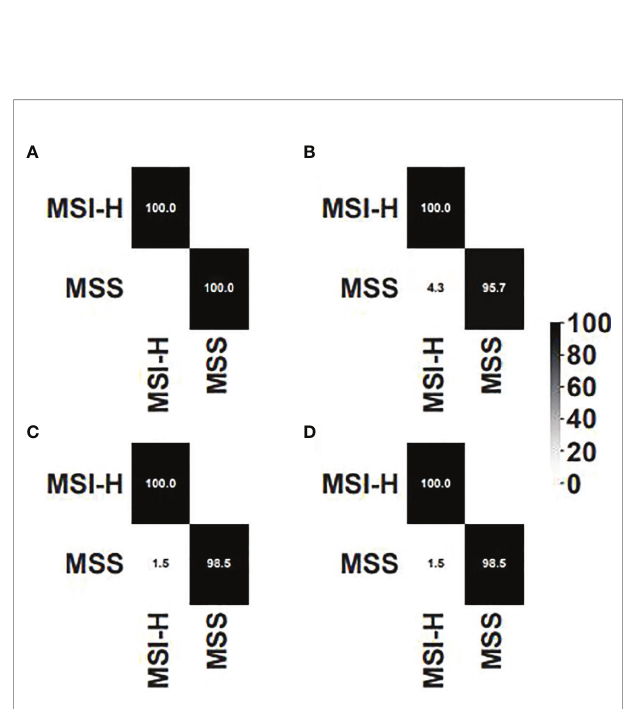
FIGURE 5 | Confusion matrix for (A) our algorithm on the validation set, (B) MSIsensor on the validation set, (C) our algorithm on the test set, and (D) MSIsensor on the test